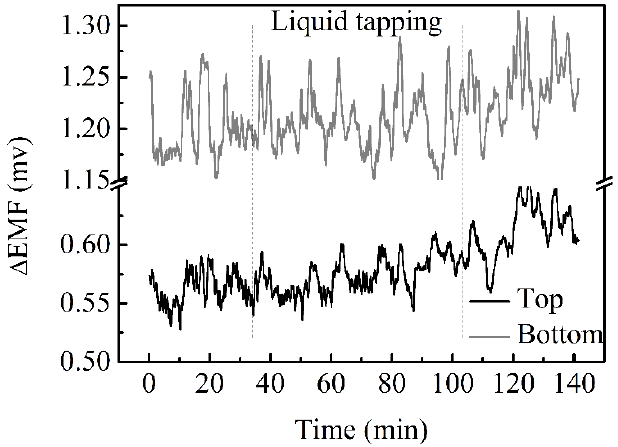
Figure 13. Effect of the height of sensor location on EMF signals.